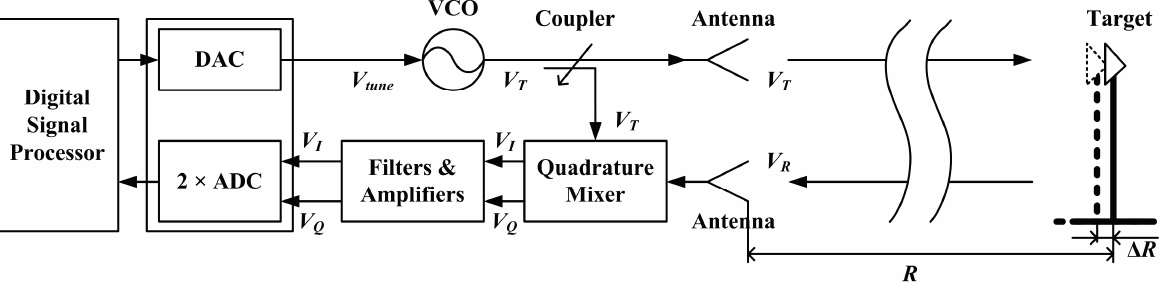
Figure 3. Schematic diagram of a FMCW radar